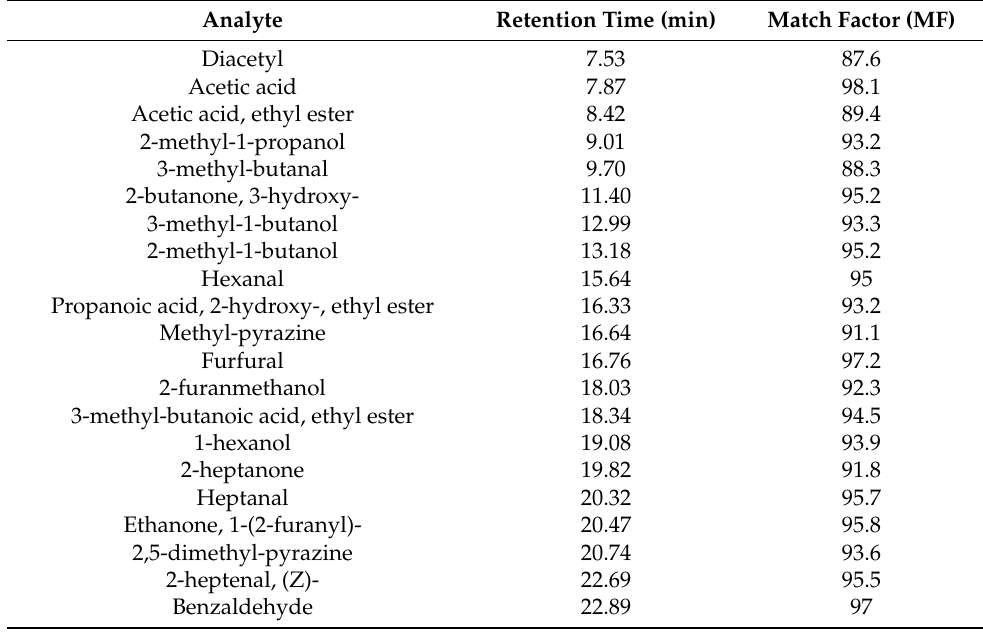
Table 1. Identi fi ed headspace volatile compounds in the bread samples with their retention time and match factor.